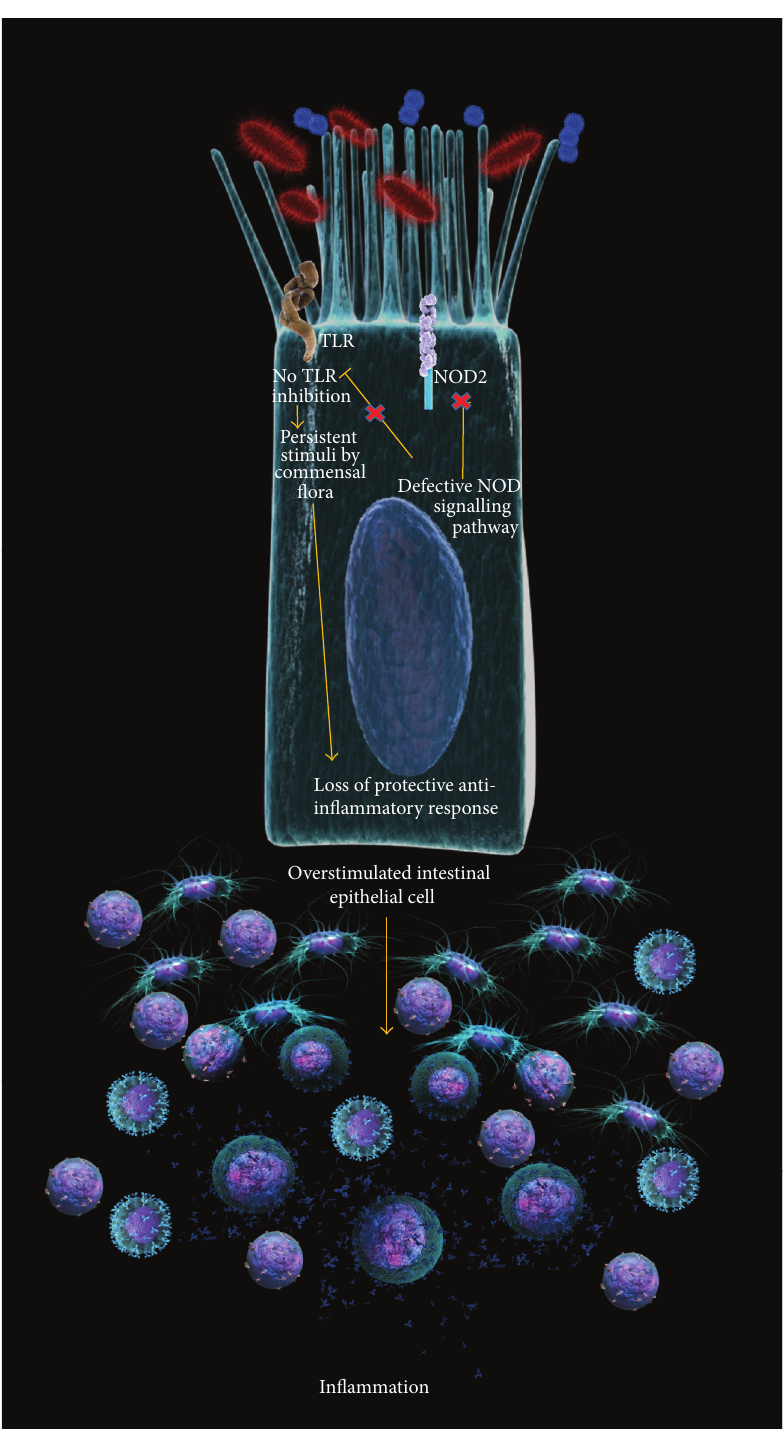
Figure 4: The paranoid overstimulated intestinal epithelial cell in Crohn’s disease. The deficiency in NOD2 inhibits an anti-inflammatory mechanism that impedes TLR2 from continual signaling if in contact with its bacterial wall ligands. The loss of this compensatory anti- inflammatory mechanism generates uncontrolled inflammation based on a threat that is not real, because the commensal flora does not